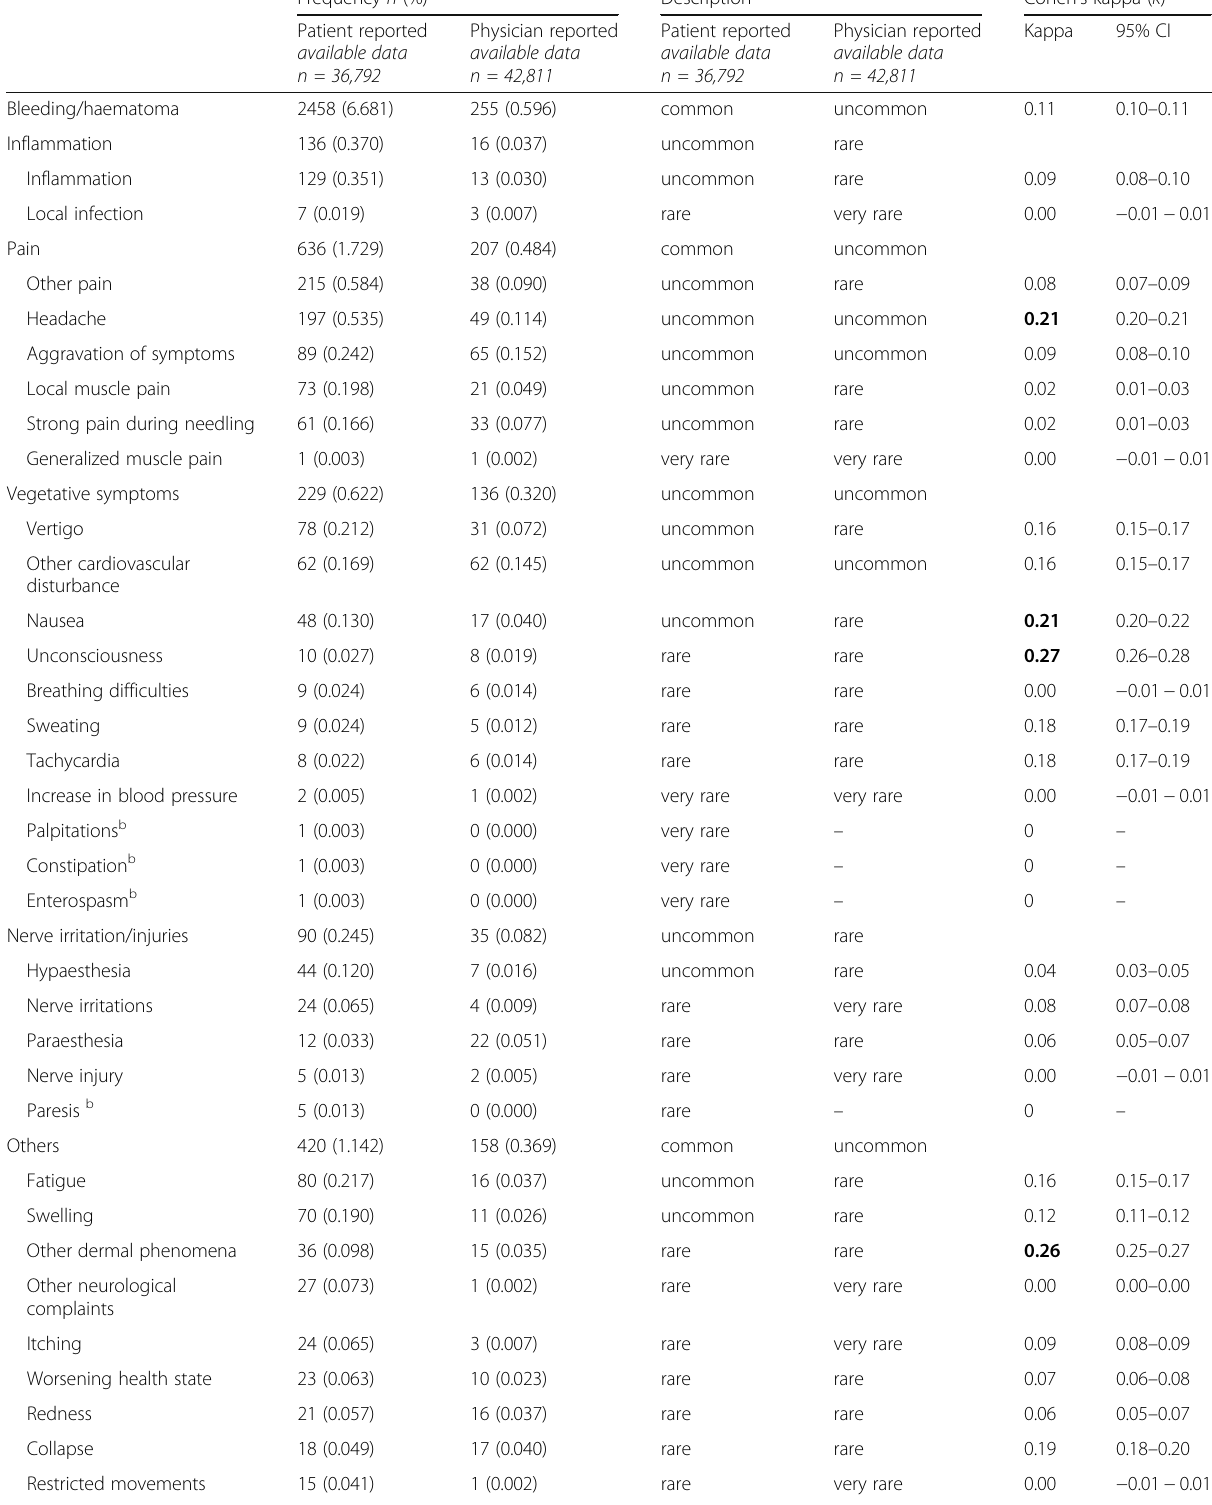
Table 2 Frequency of reported adverse reactions by patients and physicians sorted by categories in frequencies and proportions, description in text form, and agreement as Cohen ’ s kappa ( κ ) coefficient with 95% confidence interval (CI) for 36,792 and